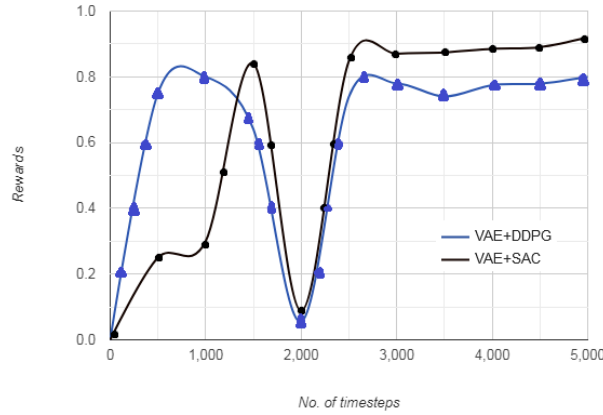
Figure 12. Comparison of rewards vs. number of training steps for VAE+DDPG and